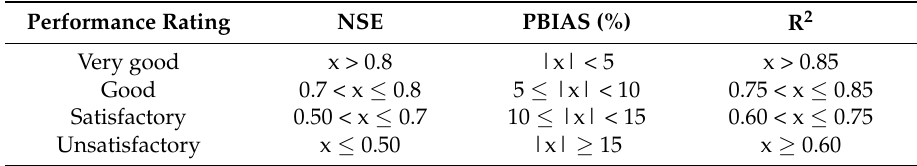
Table 3. Model performance ratings used to assess the SWAT model performance of stream